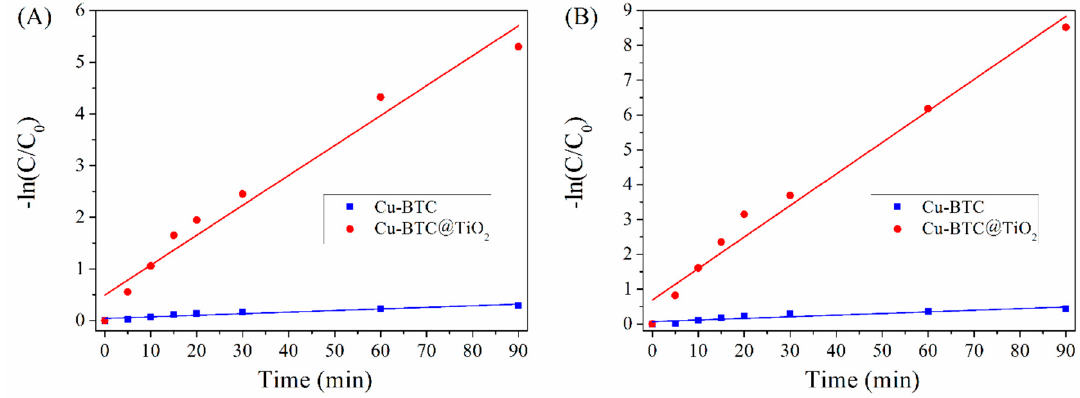
Figure 11. Effect of time on the plots of the pseudo-first-order kinetics of BT ( A ) and DBT ( B ) over Cu-BTC and Cu-BTC@TiO 2 . Table 1. Pseudo-first-order rate constants and correlation factors of the desulfurization of BT/DBT 1 . Catalysts